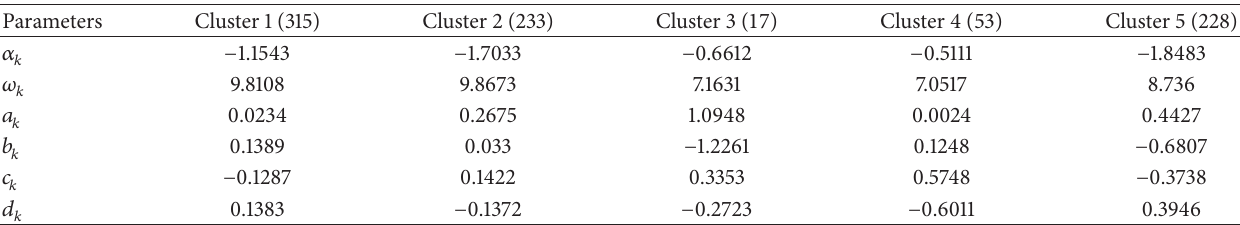
Figure 5: Plot of gene expression profiles. (a)–(e) show gene expression profiles for one of five clusters. (f) shows gene expression profiles which are determined as noises. Table 2: The model parameters for each